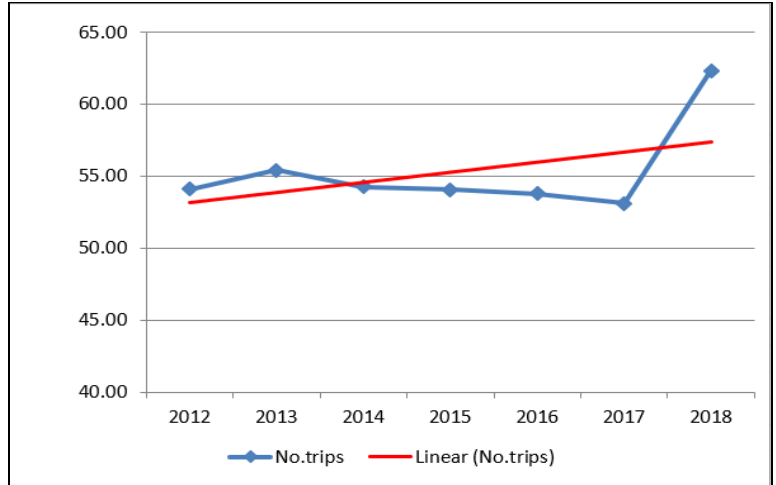
Figure 1. The number of trips in rented accommodation: campsites, caravan or trailer park, EU-27, 2012–2018 (million trips). Source: Authors’ own contribution, based on data provided by